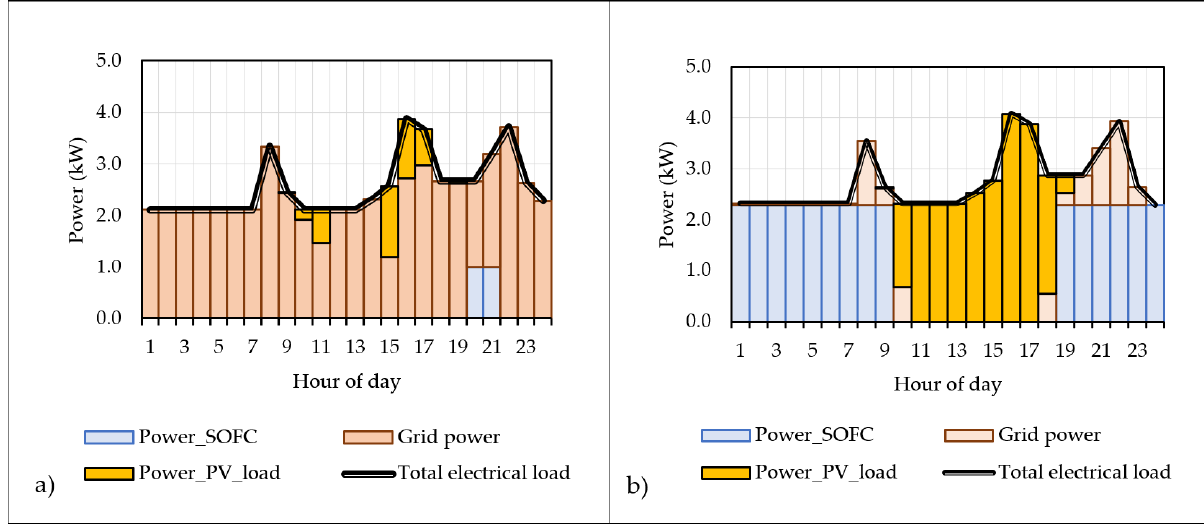
Figure 6. Power balance in an intermediate day of the winter season for ( a ) economic optimization and ( b ) energetic optimization.